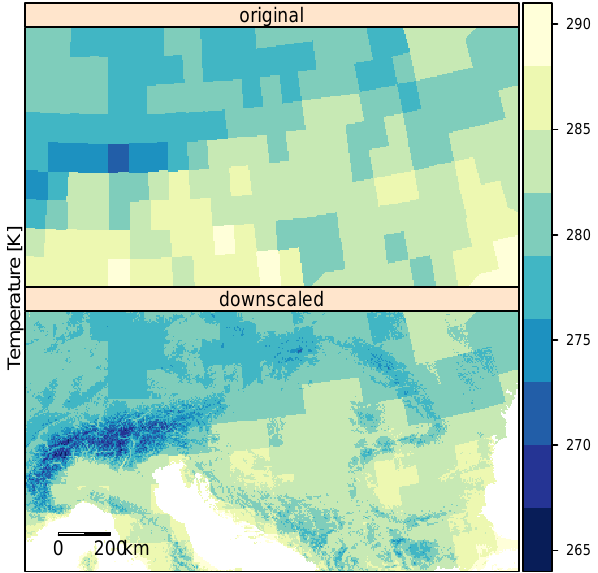
Fig. 3. Downscaling of climate variables. The panels have the same domain as Fig. 1. The upper panel shows the mean temperature on an arbitrary day, on the scale of the climate dataset (resolution ± 100km). The lower panel shows the downscaled temperature on the model scale (resolution